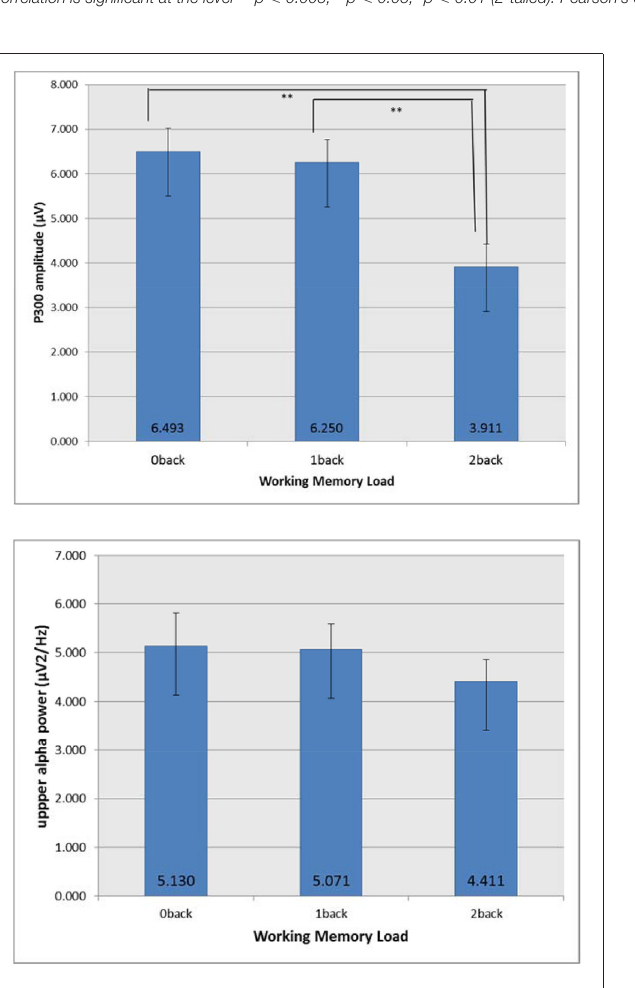
FIGURE 3 | Mean P300 amplitude and upper alpha power at Pz. The error bar indicates the 98% confidence interval of one standard error. ** p < 0.05. tools from the EEGLAB DIPFIT plug-in. Table 5 lists the cortical regions associated with Brodmann’s areas (BAs) localized during 0-, 1-, and 2-back tasks.